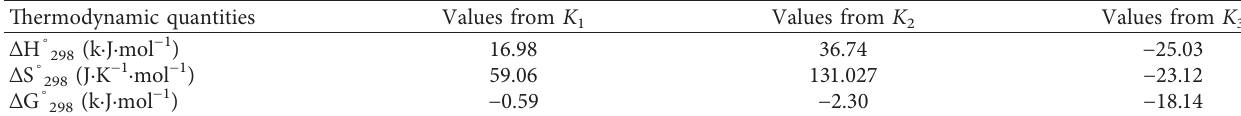
Table 5: Thermodynamic parameters from equilibrium constants for CRBC.